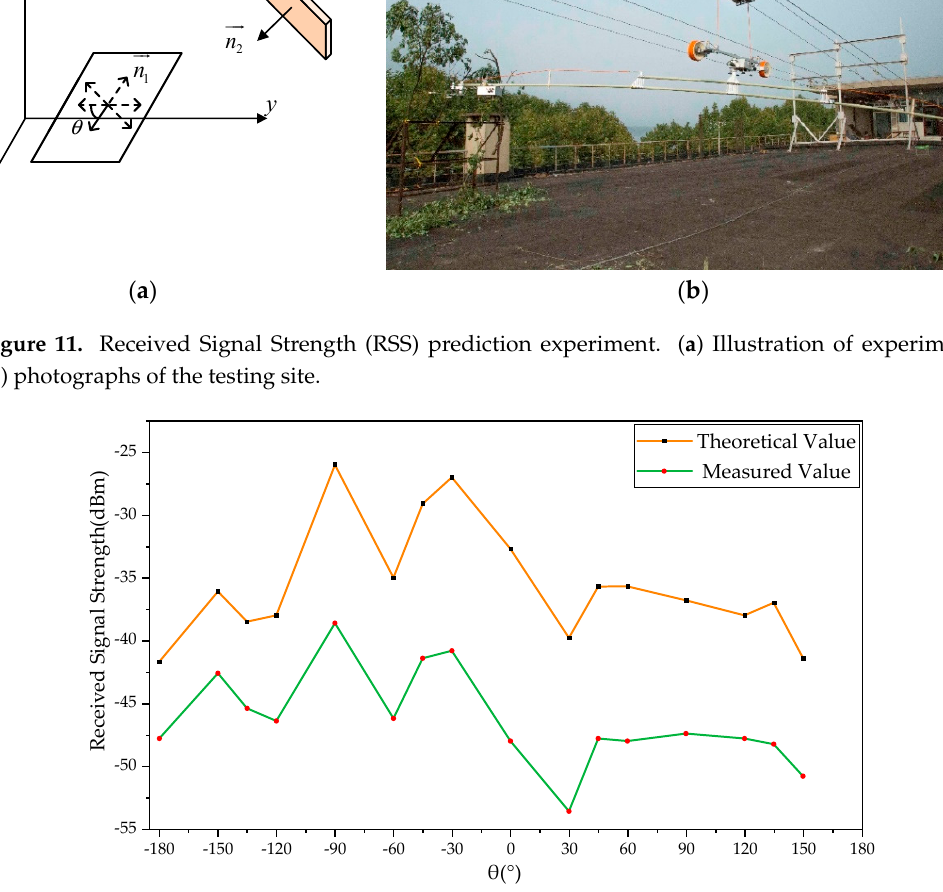
Figure 12. Theoretical value and measured value of the RSS of the BS received from the IR.